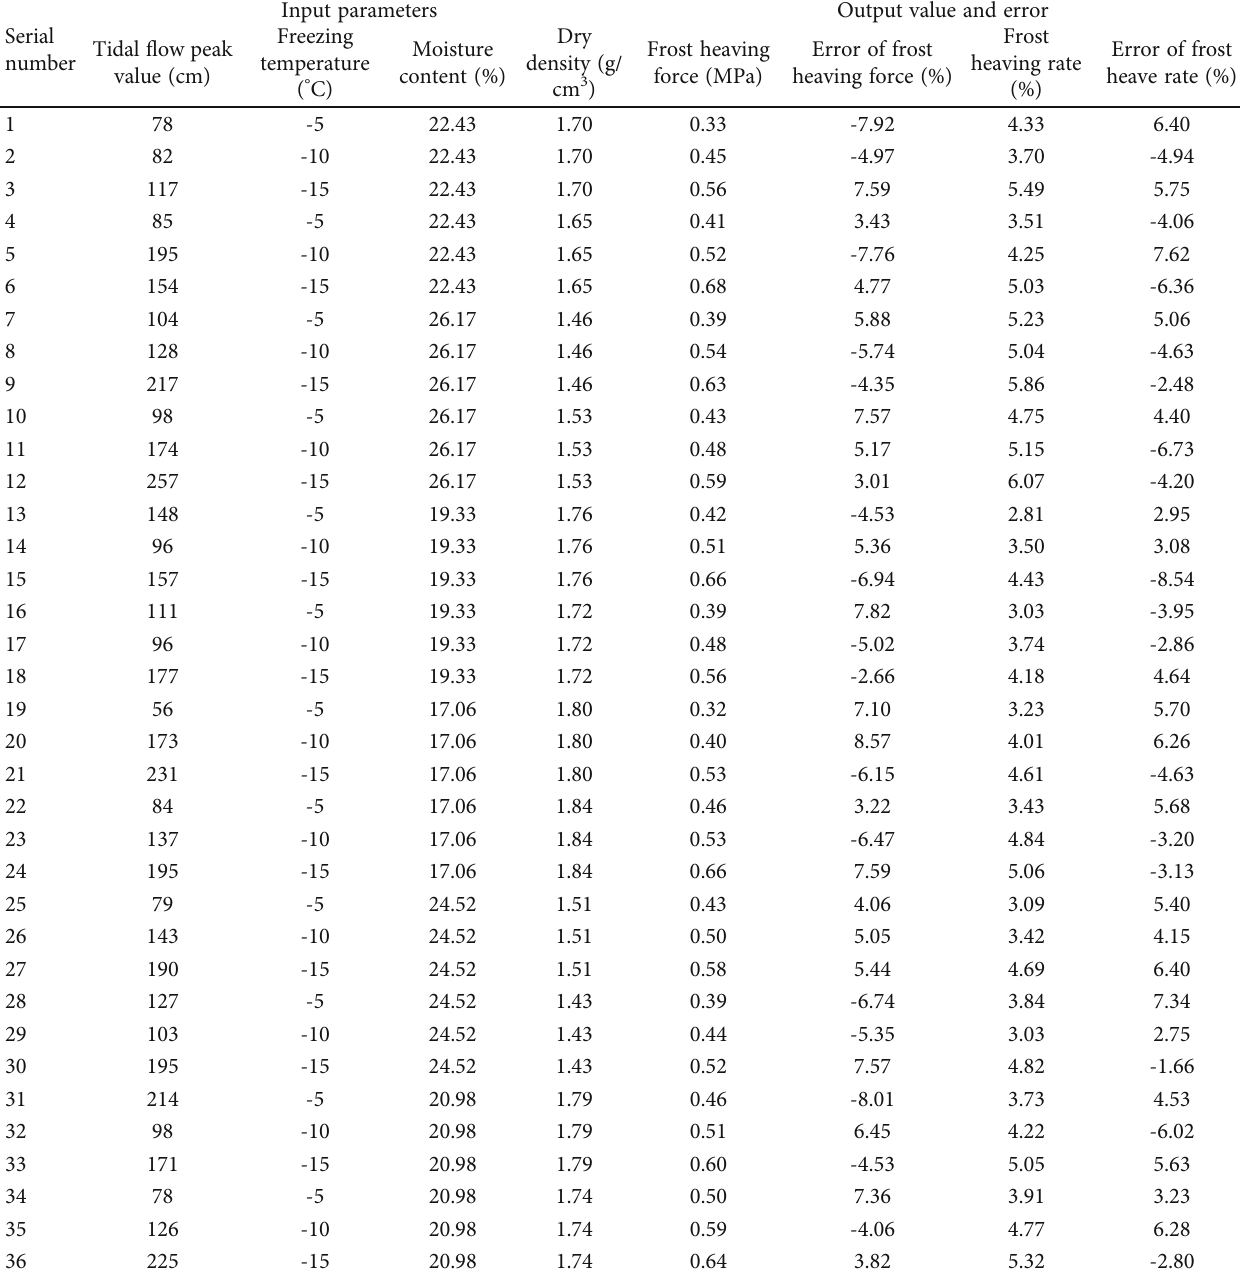
Table 3: Training results of the prediction